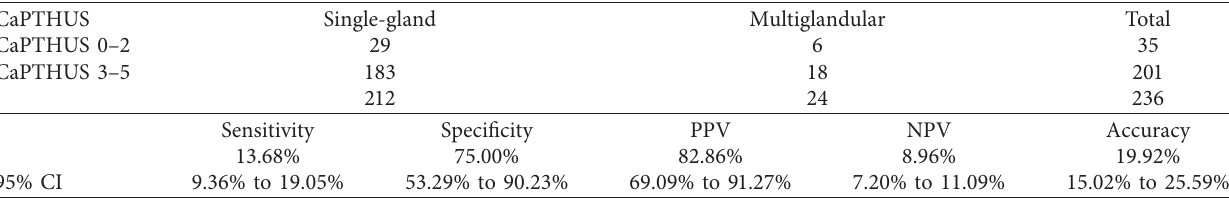
Table 9: CaPTHUS.